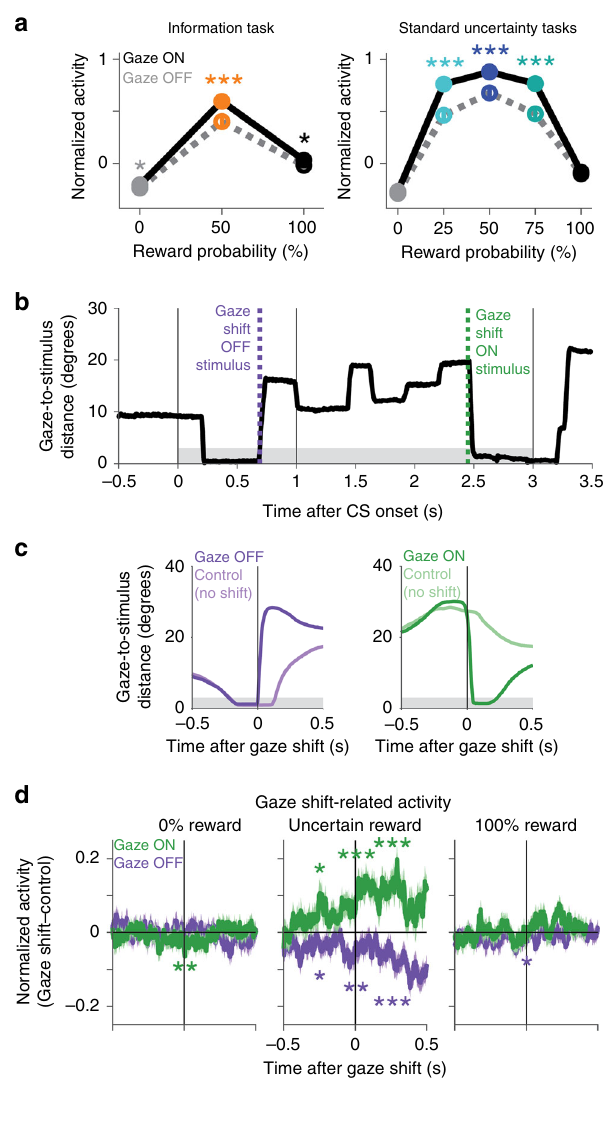
Fig. 5 Fluctuations in cortico-BG network signals predict immediate gaze shifts toward or away from objects associated with resolving uncertainty. a Mean normalized activity before information is enhanced when gaze is on the stimulus (dark dots/lines) compared with off the stimulus (light dots/ lines), especially for intermediate reward probabilities when reward is uncertain. Data are from information tasks (left) and standard uncertainty tasks (right). This analysis was performed on all neurons where there was trial-to-trial variance in gaze behavior before receipt of information for all of the CSs (information tasks n = 117: ACC n = 62, icbDS n = 24, Pal =